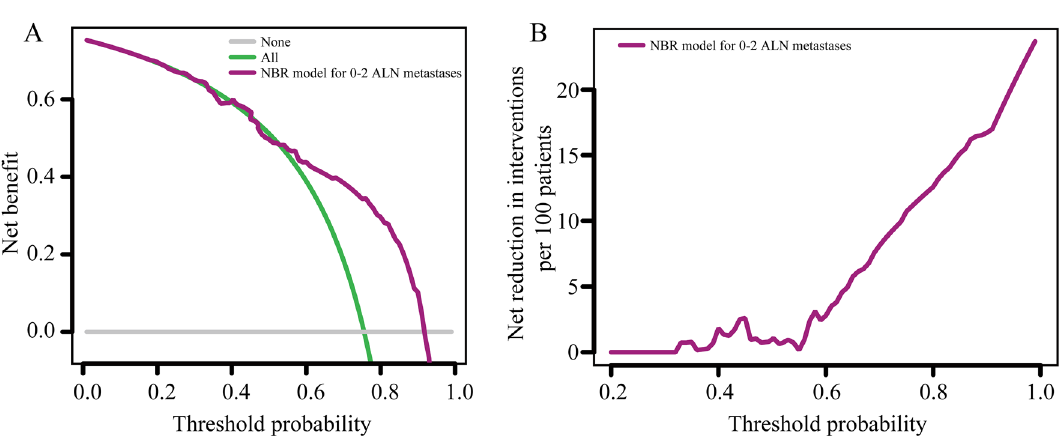
Figure 4. Decision curve analysis of the negative binomial regression (NBR) model in the validation group. ( A ) Net benefits for predicting 0–2 axillary lymph node (ALN) metastases. ( B ) Net reduction in interventions per 100 patients at different probability thresholds for predicting 0–2 ALN